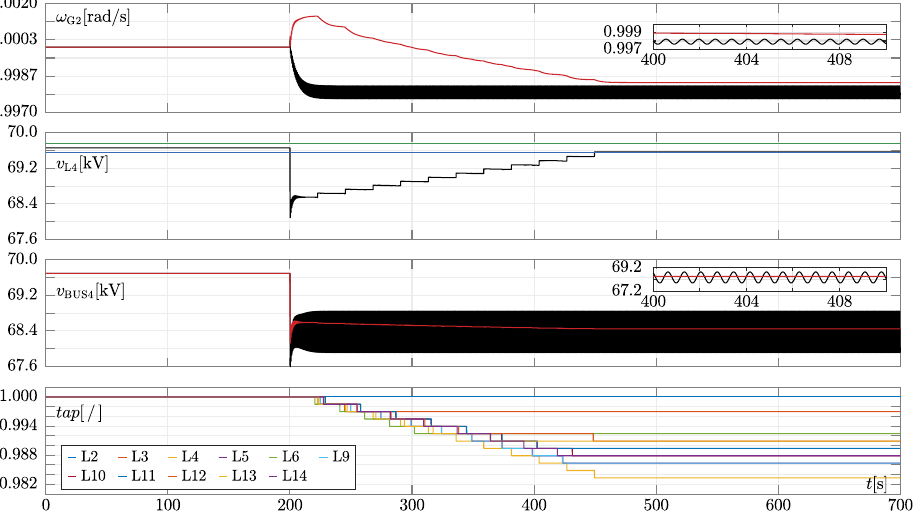
Figure 4. Simulation results of IEEE 14- P and IEEE 14- Z scenarios when a 20% overload is applied. The traces in each panel have the same meaning as those in Figure 3. Insets in the first and third panels are meant to show the oscillations that arise in the IEEE 14- P